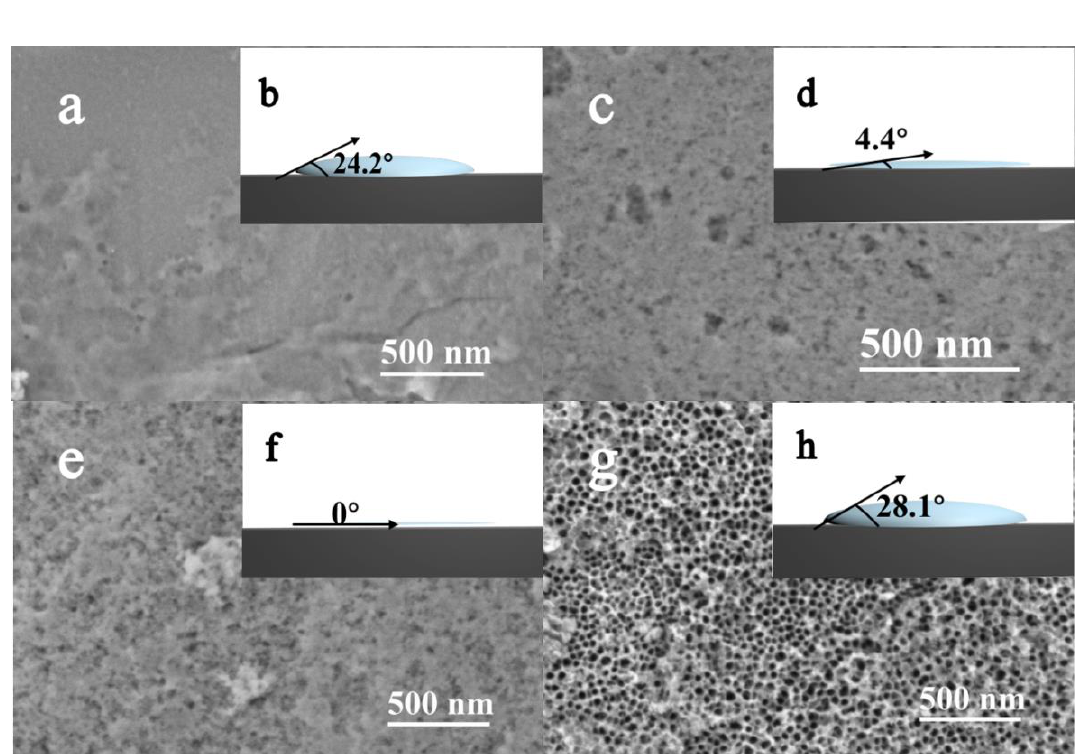
Figure 3. Surface images and corresponding contact angles of Nb 2 O 5 NAs anodized at different times during electrochemical oxidation: ( a , b ) 60 s; ( c , d ) 300 s; ( e , f ) 1800 s; ( g , h ) 7200 s under anodic voltage of 20 V.